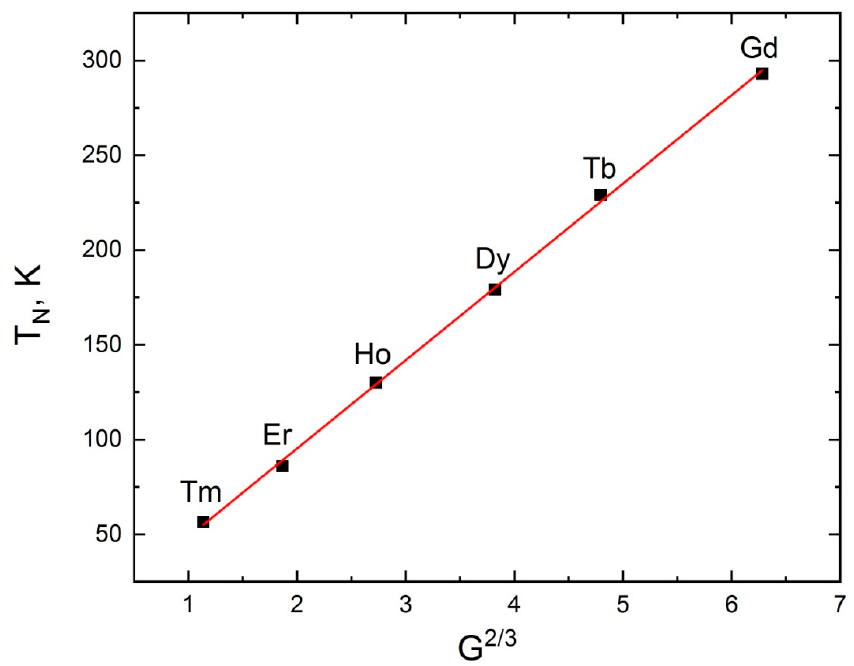
Figure 8. The Neel temperature of heavy lanthanides dependence on de Gennes function.